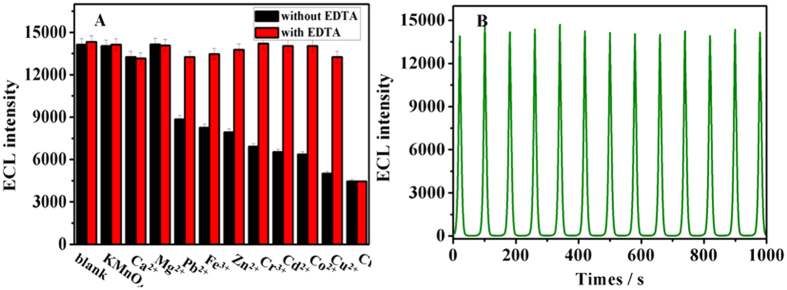
(A) Selectivity of the Au@Pb-β-CD/S2O82− system based sensor for Cr(VI) over other ions (KMnO4, Ca2+, Mg2+, Pb2+, Fe3+, Zn2+, Cr3+, Cd2+, Co2+, Cu2+, Cr2O72−) in PBS containing 0.1 M KCl, 0.1 M K2S2O8, 2 μM all metal ions and 0.1 mM EDTA. (B) Stability of ECL emissions from Au@Pb-β-CD modified-GCE under continuous scanning for 13 cycles in PBS (pH = 7.4) containing 0.1 M KCl and 0.1 M K2S2O8. Error bars = RSD (n = 3).